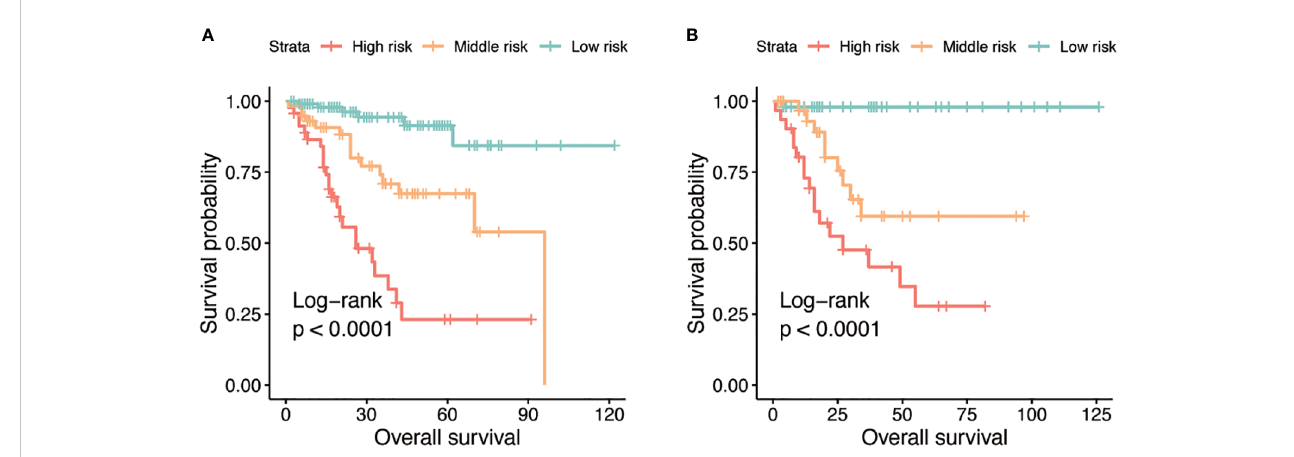
FIGURE 4 Kaplan-Meier curves for OS strati fi ed by three risk groups in the training (A) and validation (B)